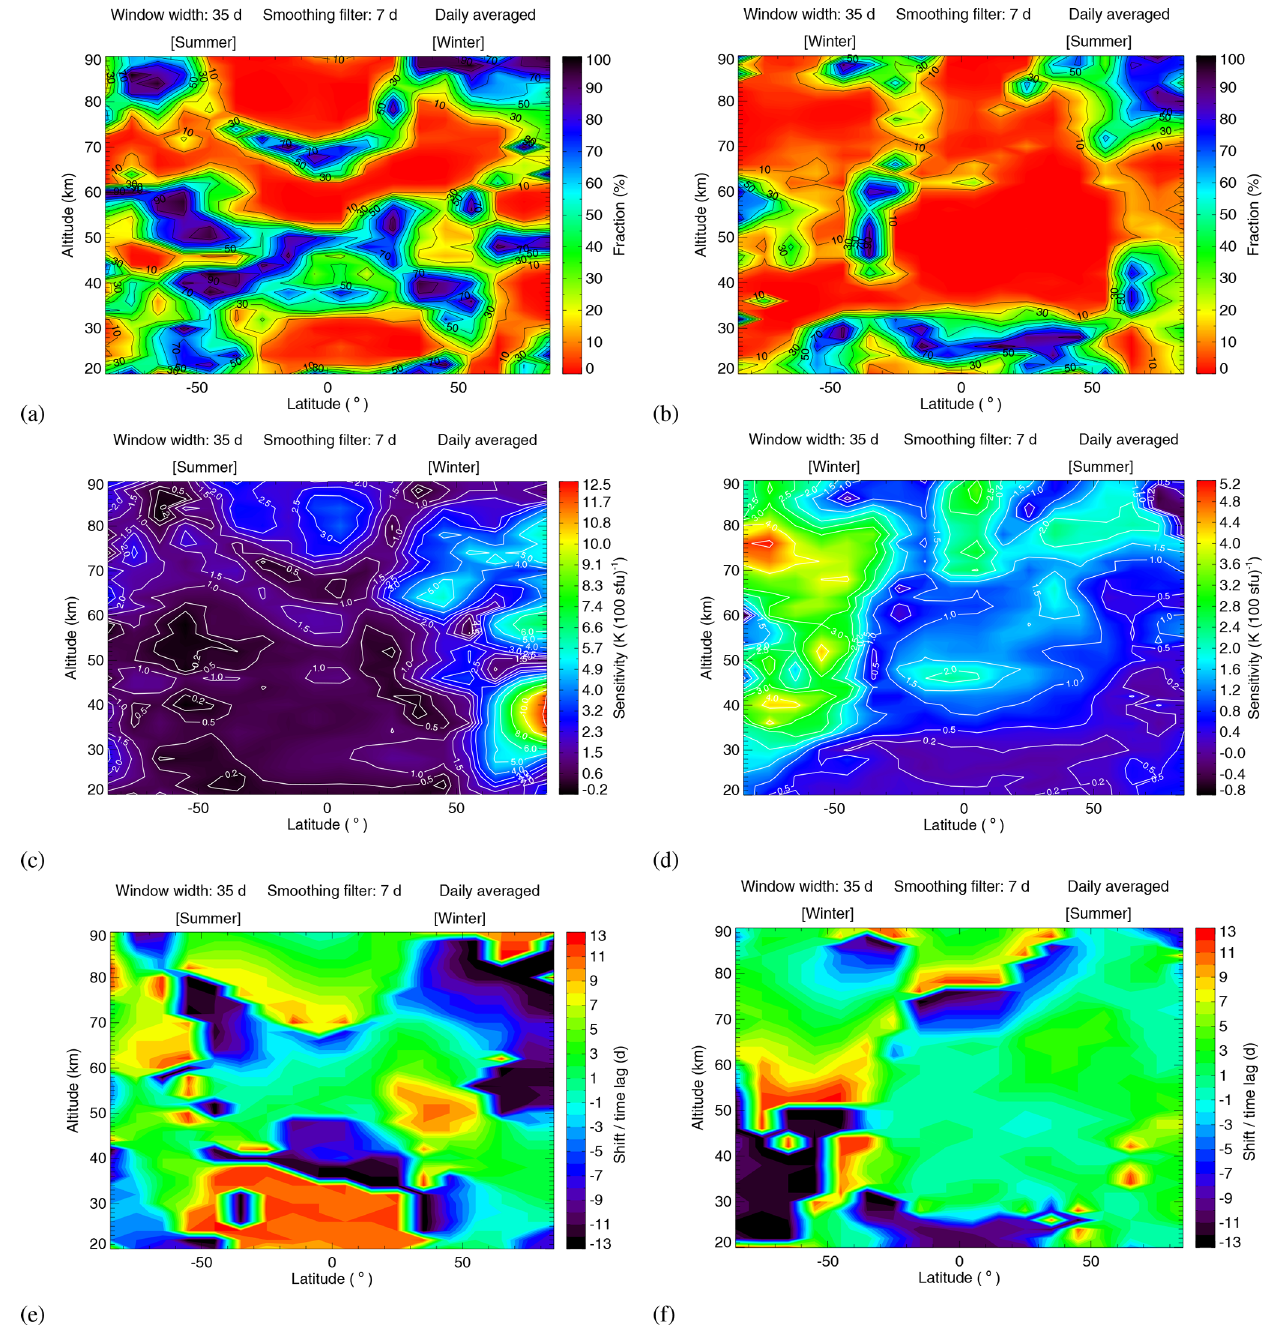
Figure 11. (a–b) Similar to Fig. 9a, except for different seasons. (c–f) Sensitivity and shift for latitudes from 85 ◦ S to 85 ◦ N and altitudes from 20 to 90km for different seasons. Panels (a) , (c) and (e) are the results for the time range from October to March (northern winter/southern summer), and panels (b) , (d) and (f) are the results for the time range from April to September (northern summer/southern